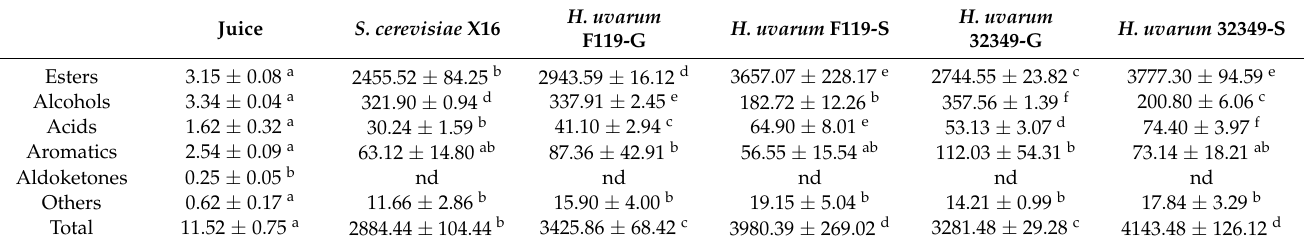
Table 4. Volatile aroma compound content (mg/L) in plum juice and plum fruit